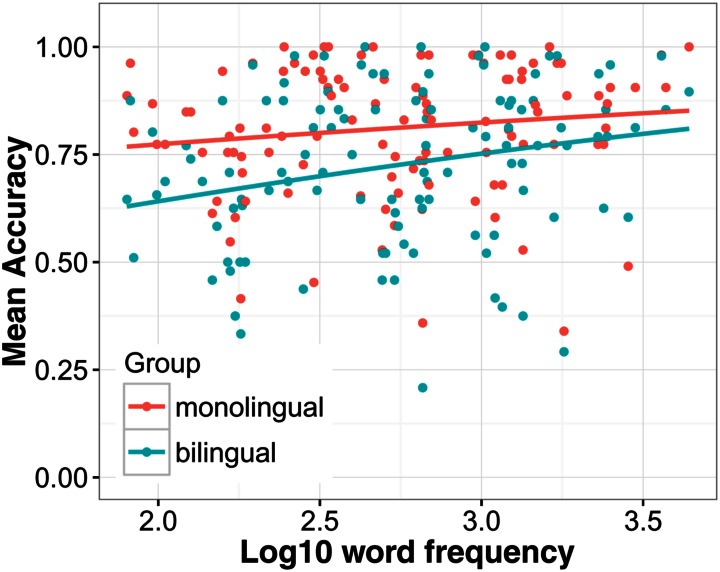
The effect of word frequency on speech understanding in noise accuracy. Regression lines show the best fit. Each dot represents the mean accuracy for a certain word in each group.